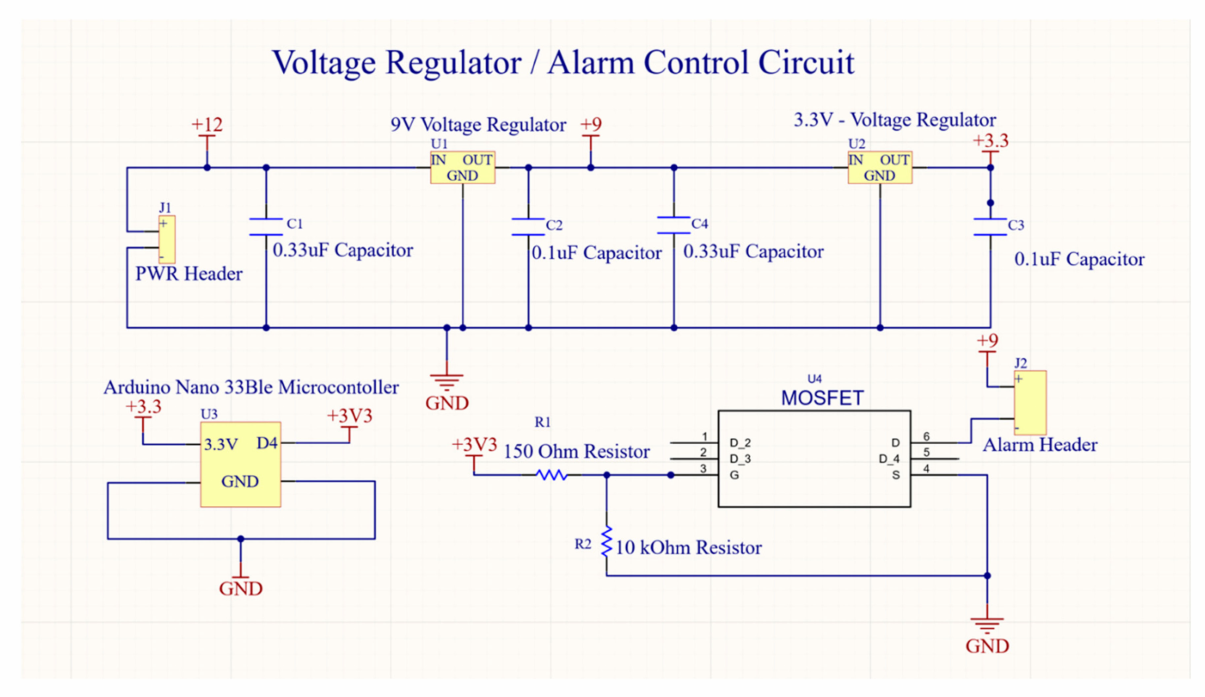
Figure 3. DiAtach alarm control